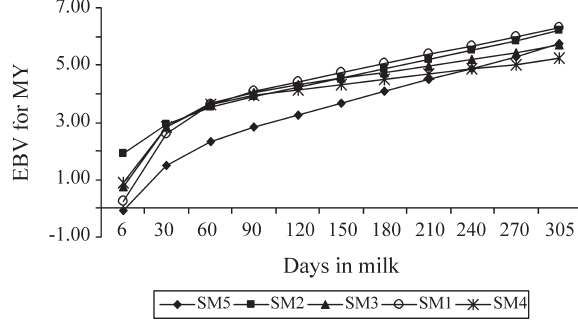
Figure 2 - Dispersal in ranking of sires with more than 25 daughters for 305-day milk yield (305MY) and persistency of lactation (PS 5 ).